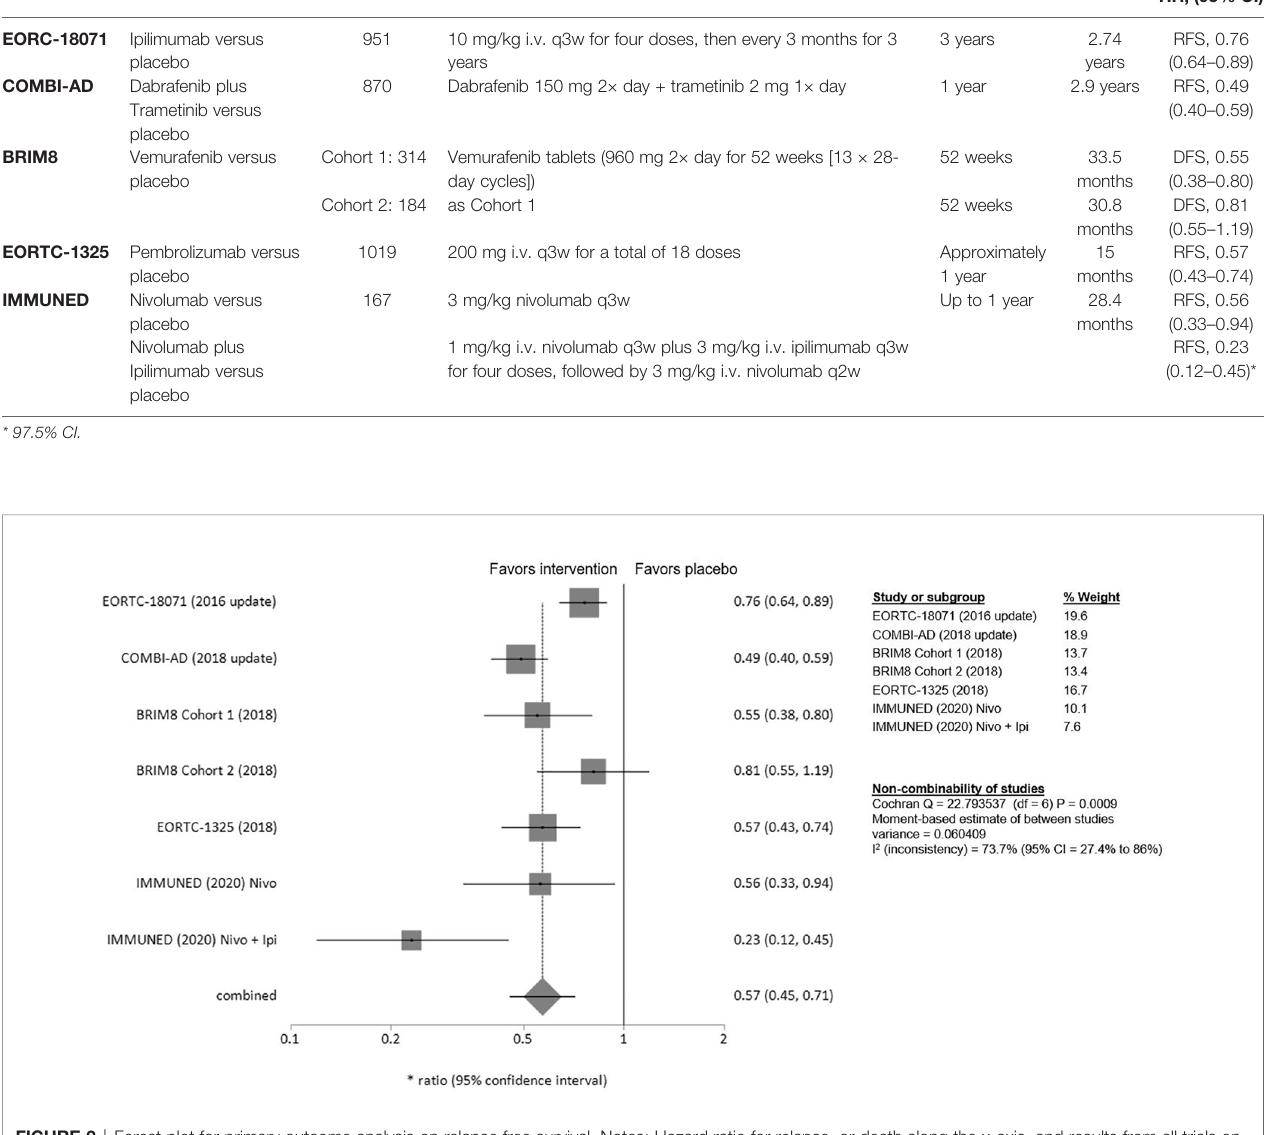
Median treatment follow up